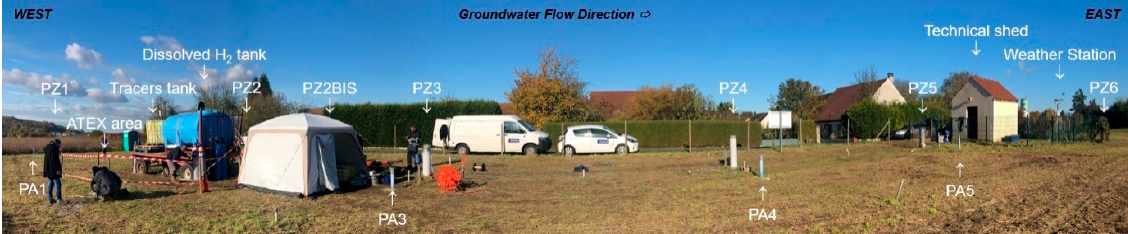
Figure 4. View of the experimental site during the experiment.